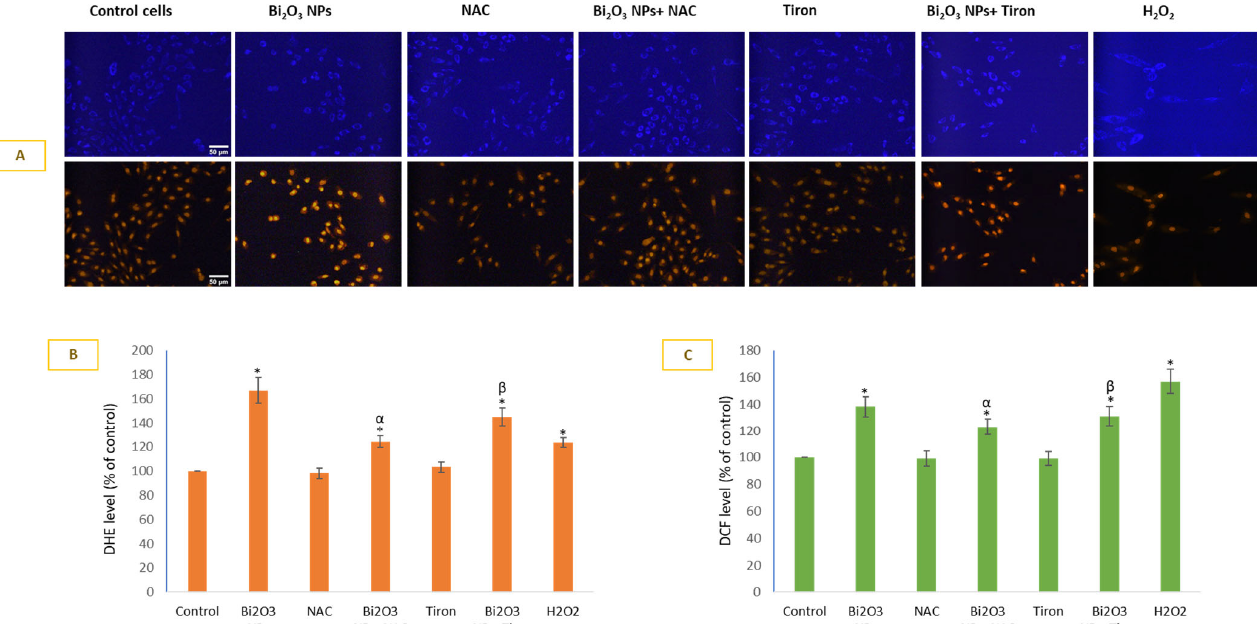
Figure 2. Production of O 2 •− was measured by DHE live imaging ( A ) and DHE fluorescence calculation ( B ) in ImageJ software. DCFHDA was used to detect H 2 O 2 ( C ). Data represented are mean ± SD of three identical experiments ( n = 3) conducted in triplicate. * Statistically significant difference compared to the controls ( p < 0.05). Any significant ( p < 0.05) difference in response from that mediated by NPs and the addition of either NAC or Tiron is denoted by α and β , respectively.